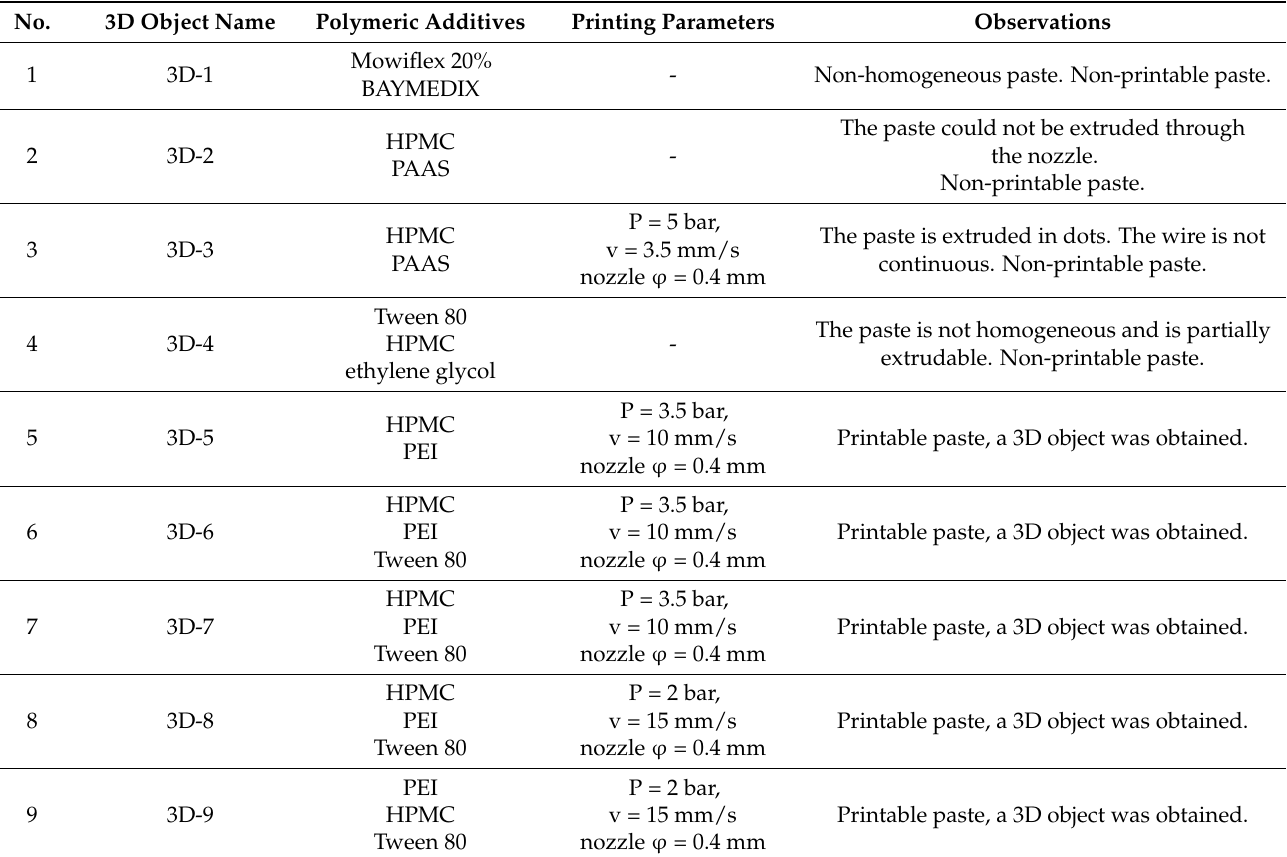
Figure 11. An example of CNT-ZnO 3D printed structure (3D-9 sample) at normal scale and microscopic scale. Table 5. The composition of printable pastes used for the manufacture of 3D structures from CNT-ZnO-2